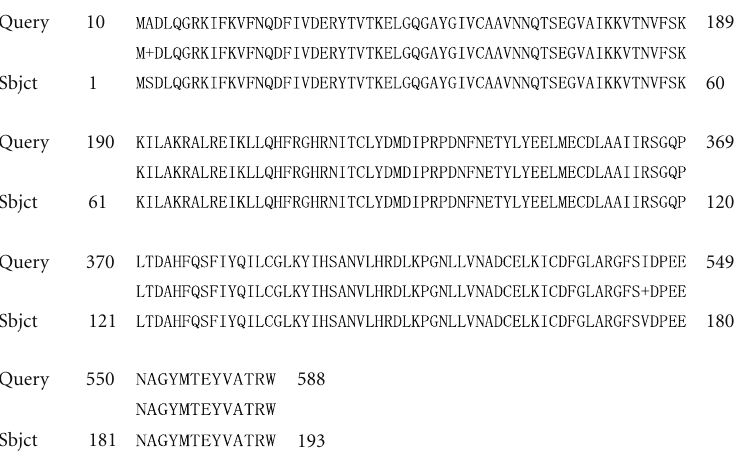
Figure 2: DV548513 shared 98% identity with MAP kinase of Gibberella intermedia .